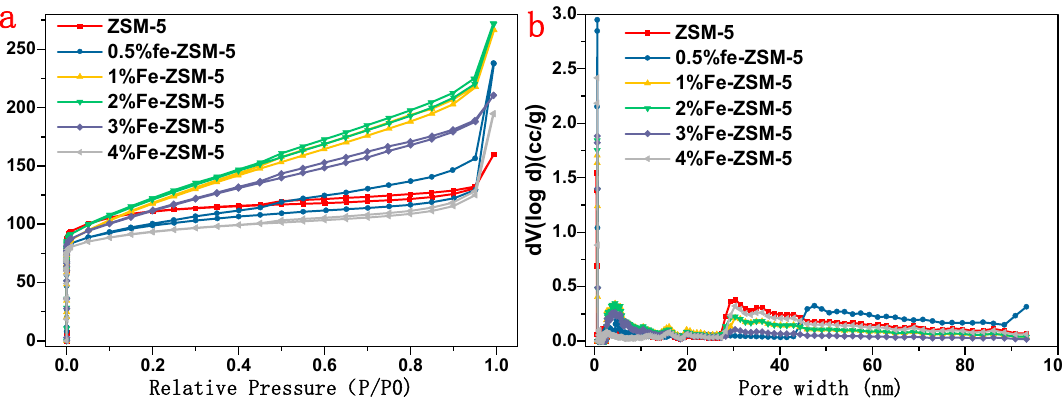
Figure 4. N 2 adsorption and desorption isotherms ( a ) and pore size distribution ( b ) diagram of dif- ferent